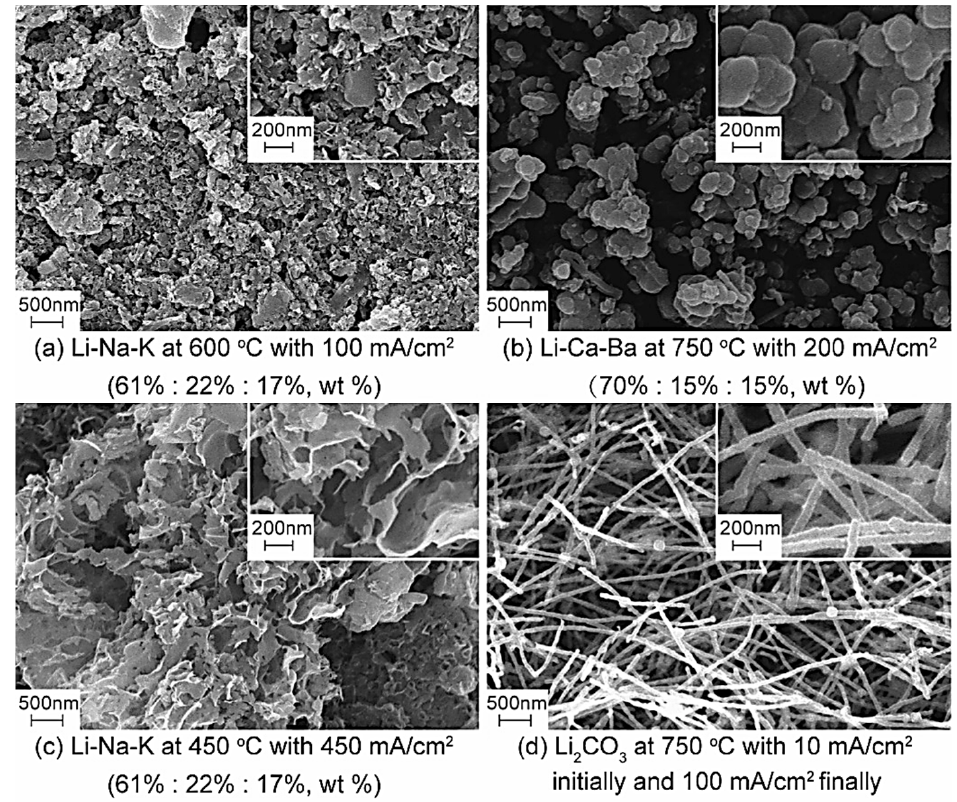
Figure 3. SEM of the carbon materials under different